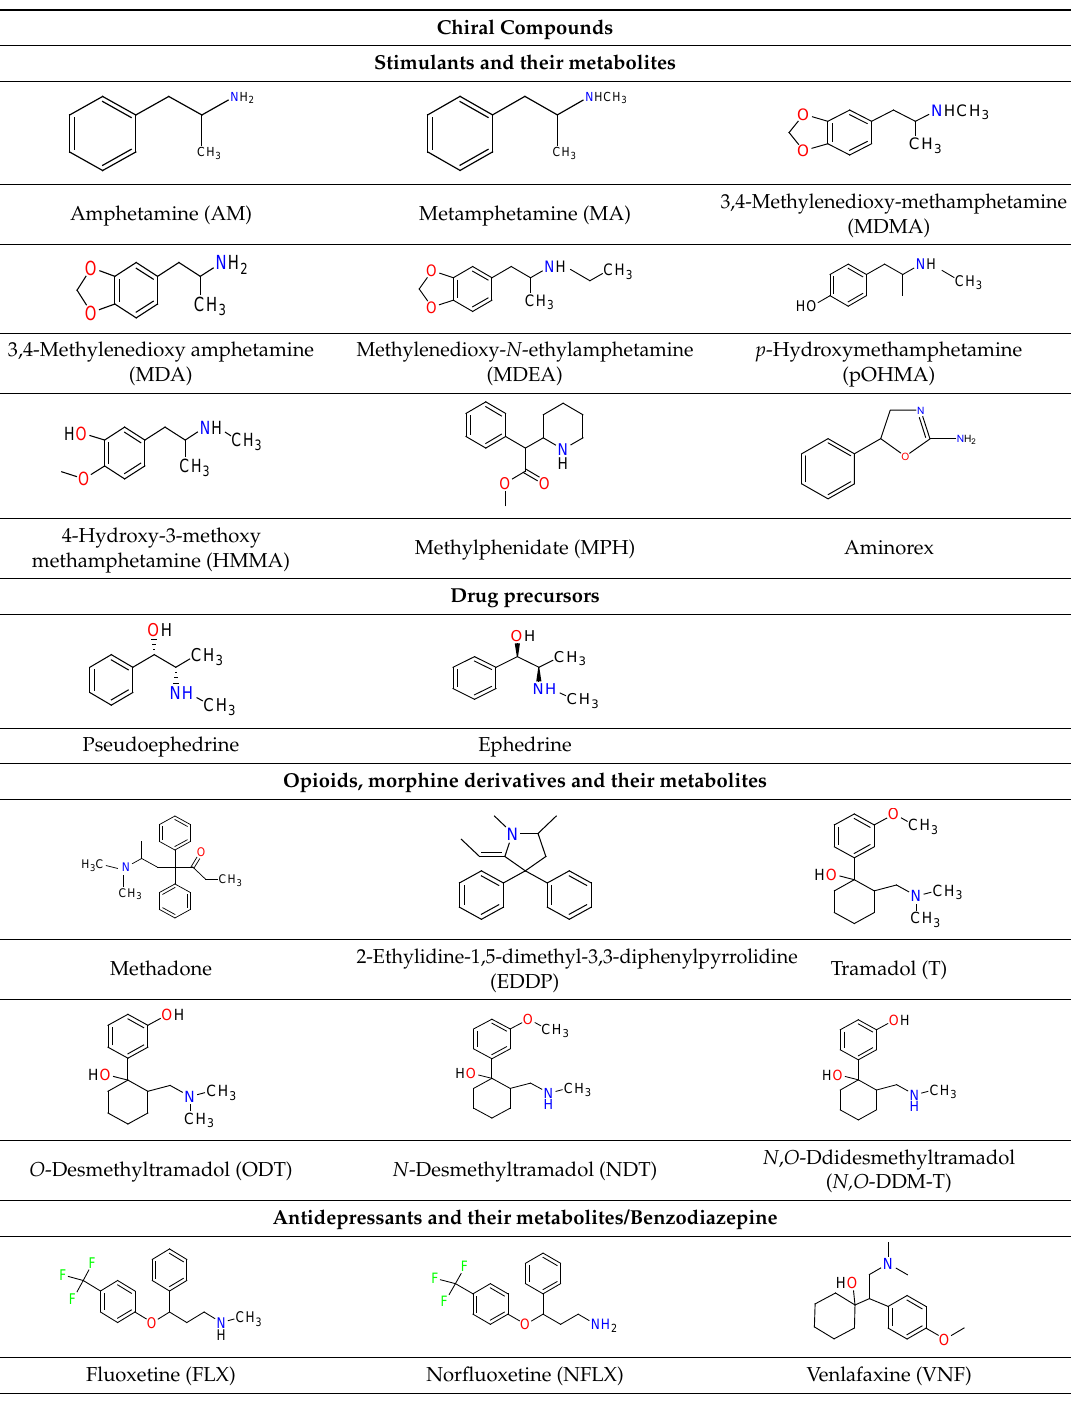
Table 1. Structures of the chiral illicit drugs and pharmaceuticals. Chiral Compounds